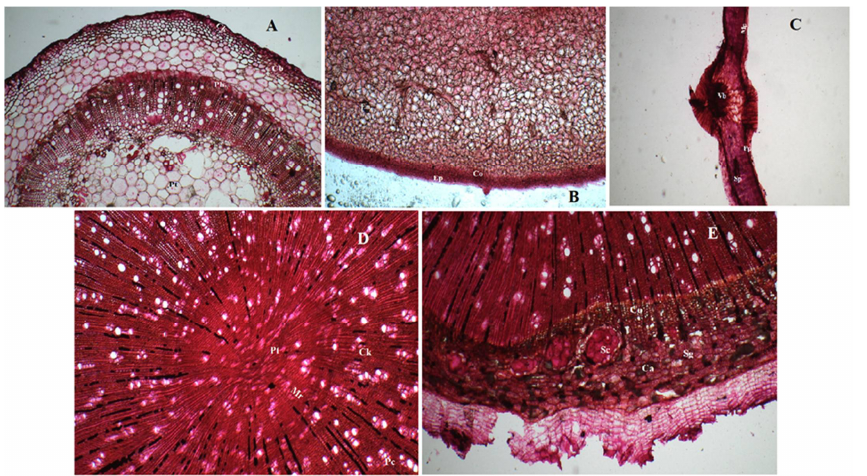
Figure 1. Microscopic evaluation of the whole plant of Solanum xanthocarpum Schrad. & Wendl. ( A ) Transverse section of stem which shows the presence cork (Ck) having thin-walled hexagonal cells followed by 6–7 layers of cork cambium (Cb). Phloem (Pb) shows the presence of fibres Xylem (Xy) shows the presence of tracheids, vessels, fibres and parenchymatous cells traversed by xylem rays. Pith (Pt) is wide, located in the centre. ( B ) Transverse section of fruit showing a single layer of epidermis (Ep) covered with a thin cuticle followed by a layer of collenchymatous cells (Co). The endosperm (En) shows the presence of oil globules. ( C ) Transverse section of leaf midrib having biconvex shape illustrating the presence of bicollateral vascular bundles (Vb), mesophyll cells (MP) along with palisade parenchyma (Pp) and spongy parenchyma (Sp). ( D , E ) Transverse sections of root depicting the presence of central pith (Pt), medullary rays (Mr), cork (Ck) comprised of thin-walled rectangular cells, pericycle (Pc), stone cells (Sc), calcium oxalate crystals (Ca) as sandy masses and simple starch grains (Sg) in the secondary